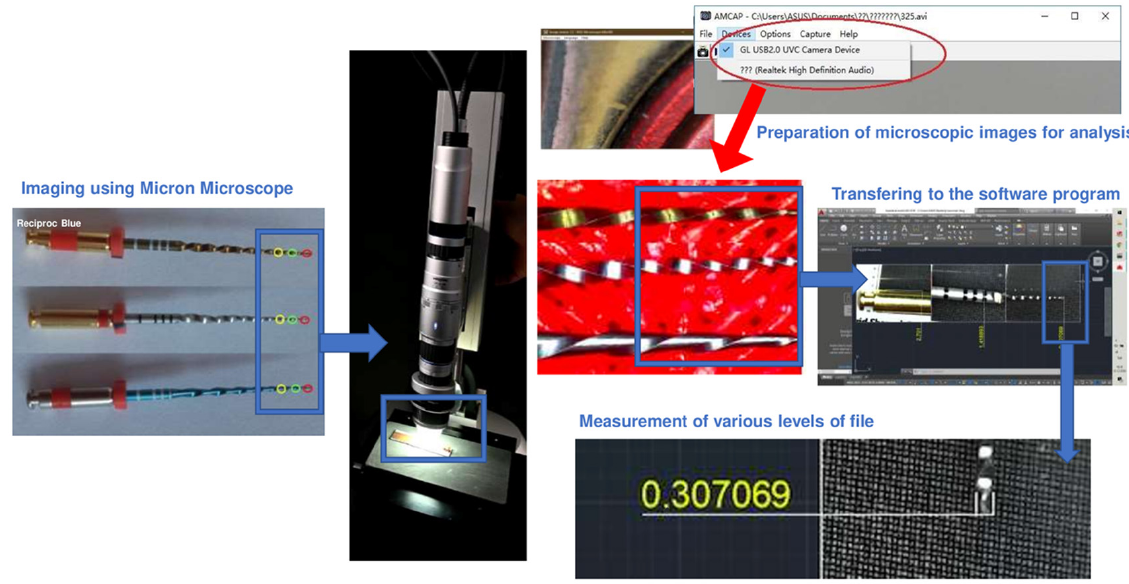
Figure 1. Stages of evaluation of wear of files caused by instrumentation.